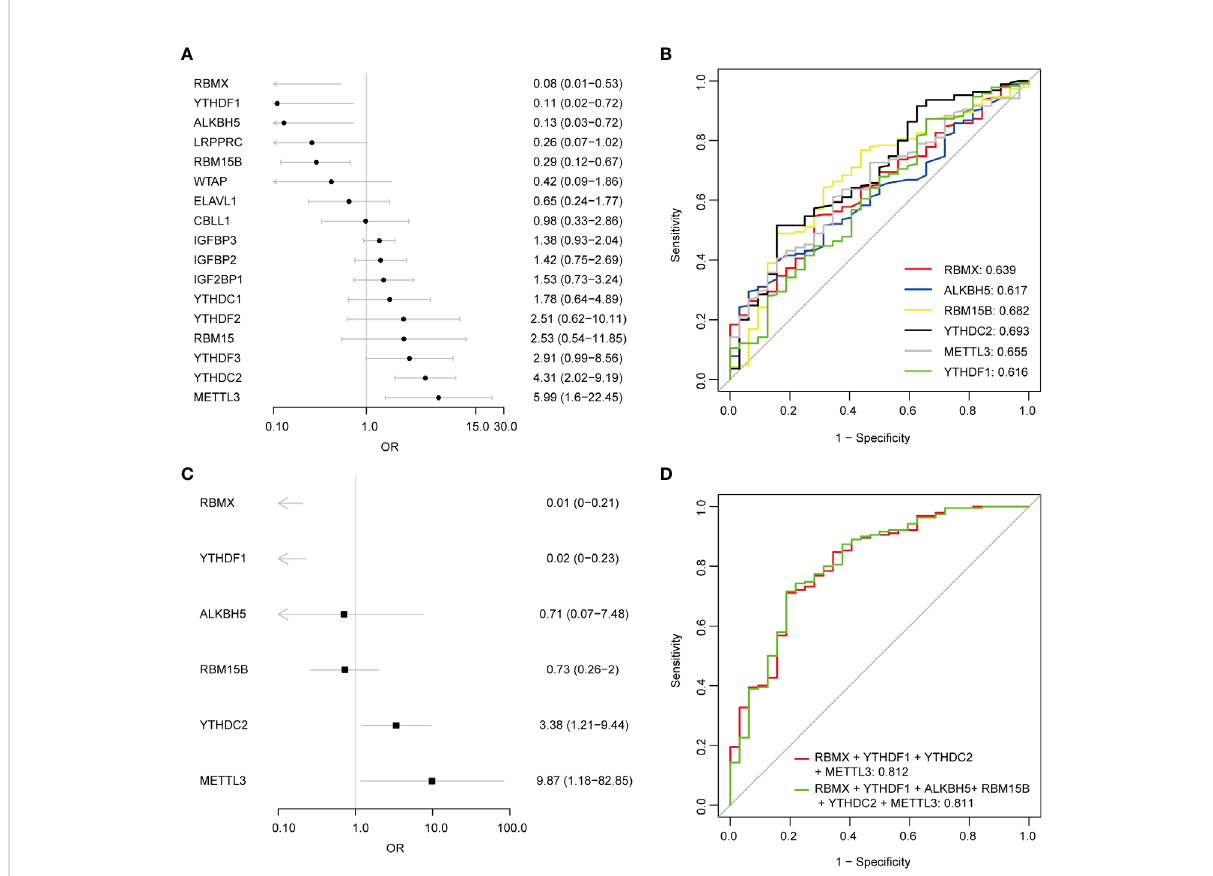
FIGURE 3 Logistic regression models investigating the relationship between m6A regulators and pSS. (A) Univariate logistic regression investigated the relationship between m6A regulators and pSS. (B) The discrimination ability of the 6 DEMRs for HCs and pSS samples was analyzed by ROC curve and AUC value. (C) Distinguishing signature was developed by multivariate logistic regression. (D) The discrimination ability of the m6A regulator panels for HCs and pSS samples was analyzed by ROC curve and AUC